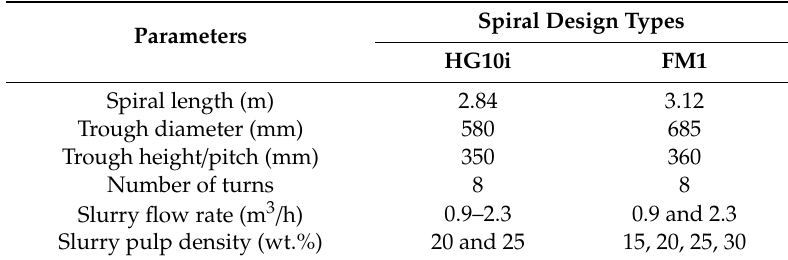
Table 1. The process parameters during the spiral concentrator